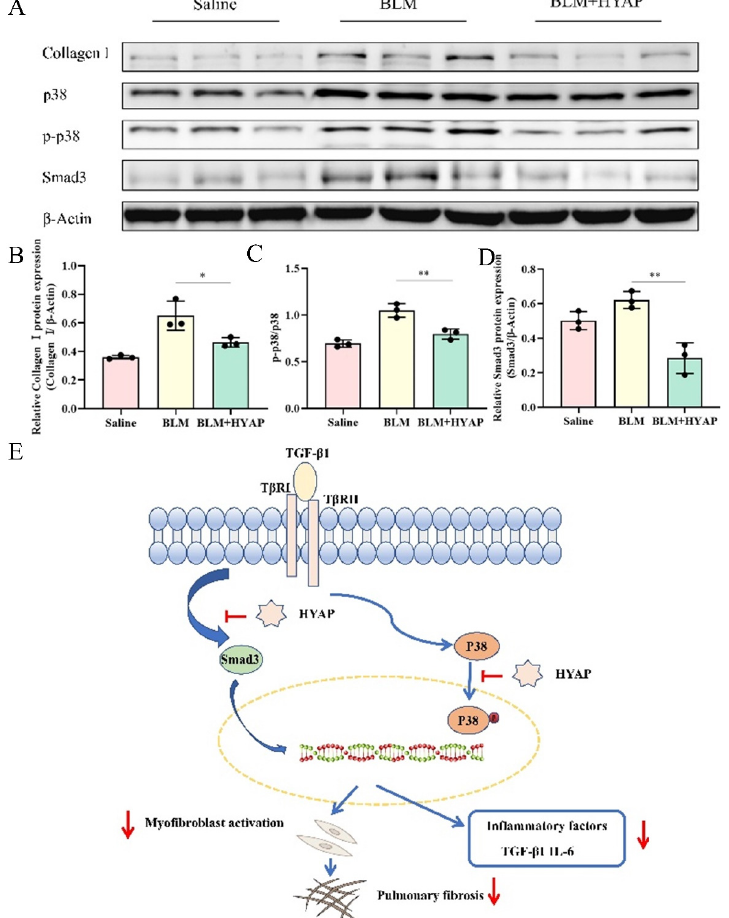
Figure 5. Expression of inflammation-related proteins after treatment. ( A ) Western blotting analysis of collagen I, p38, p-p38, and Smad3 expression levels in lung tissues after different treatments ( n = 3). ( B – D ) Analysis of the expression of collagen I, p-p38/p38, and Smad3 in the lungs after different treatments ( n = 3). Quantification was performed using Image J software. * p < 0.05, ** p < 0.01. ( E ) HYAP improved BLM-induced lung fibrosis by blocking the MAPK-p38 and TGF- β /Smad signaling pathways, thereby inhibiting secretion of related inflammatory factors and fibroblasts’ proliferation.